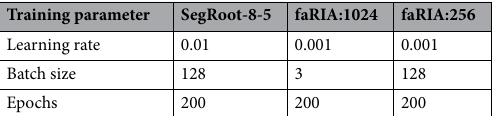
Training parameter SegRoot-8-5 faRIA:1024